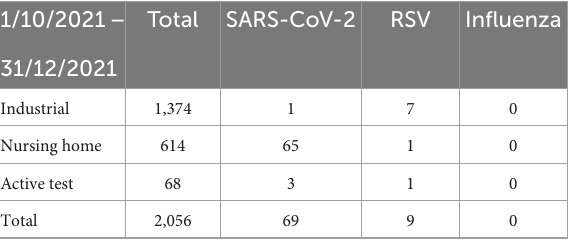
TABLE 1 Distribution of infections in each study group for the last trimester of the year 2021.